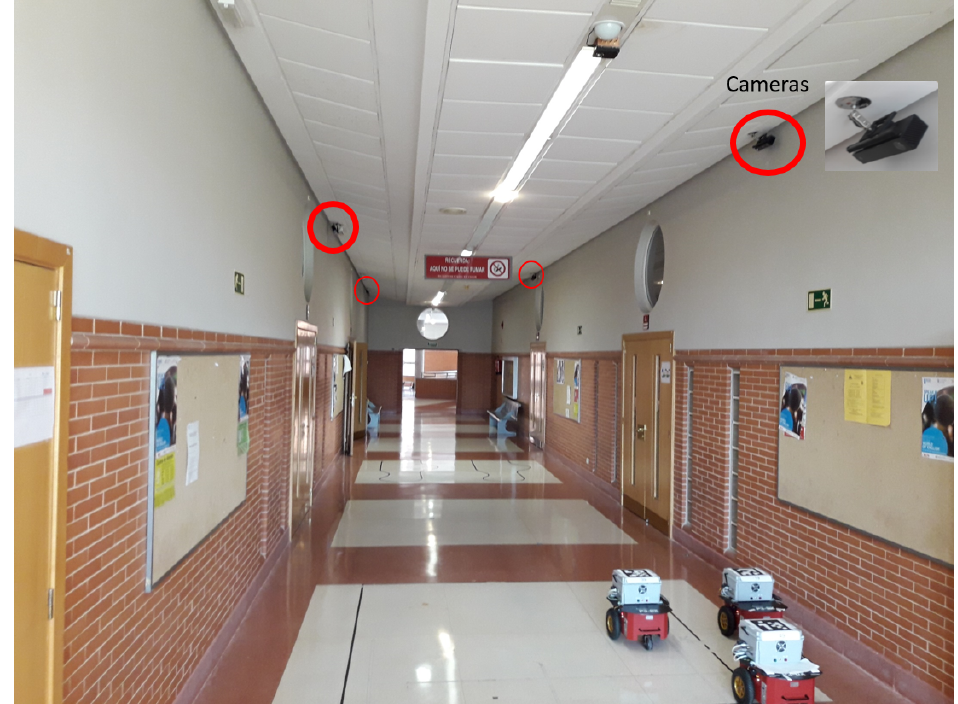
Figure 9. Picture of the working area with four Kinect 2 camera sensor and the formation of three P3DX robot wirelessly controlled by a